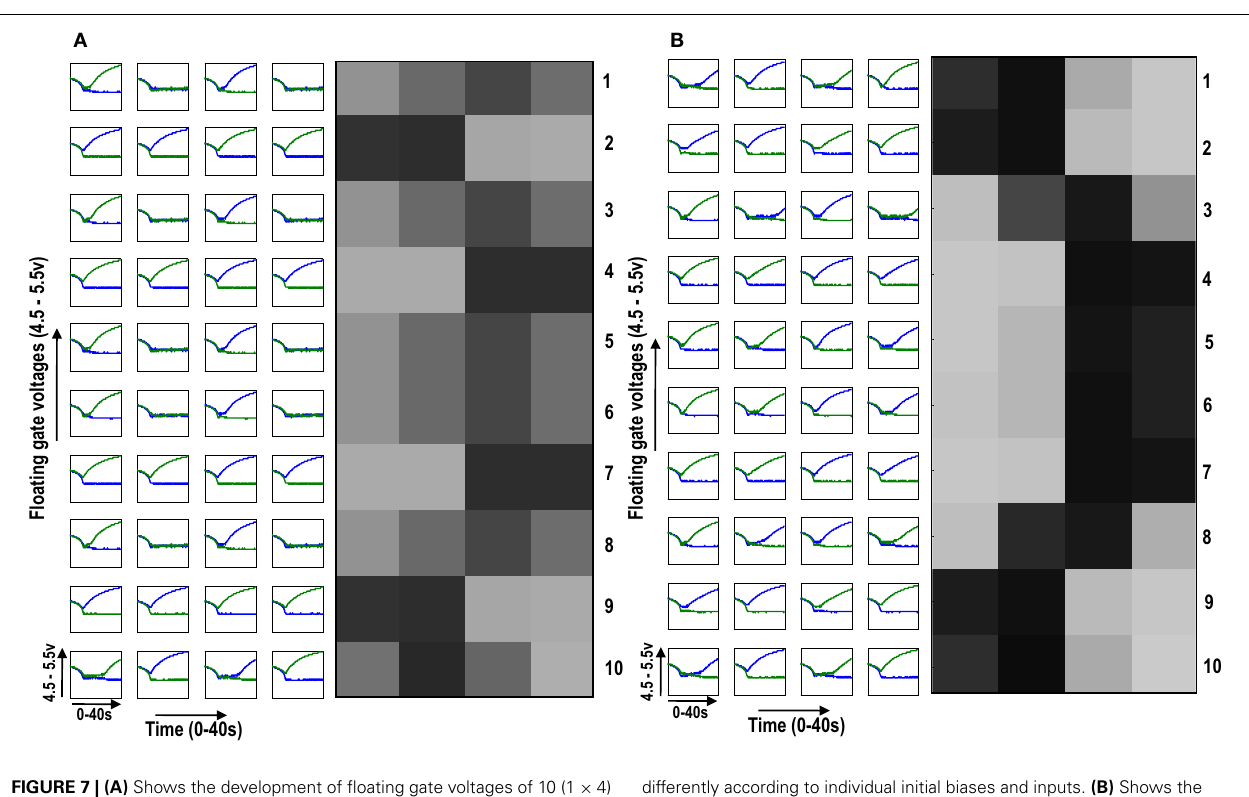
differently according to individual initial biases and inputs. (B) Shows the same 10 cells when they interact diffusively. Near neighbor cells begin to cluster developing similar feature preference. Between two opposite patterns (e.g., 1100 and 0011) , there is a gradual variation (1001), see responses of Cells 2, 3, and